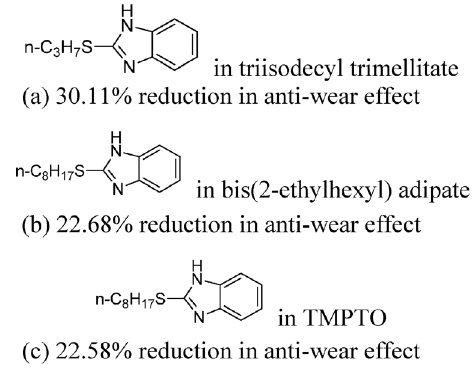
Fig. 27 The structural formula of the compound.